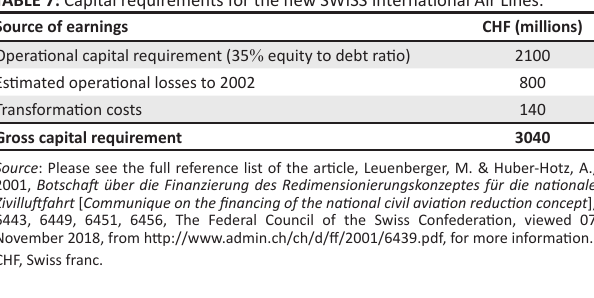
TABLE 8: Percentage shareholding in SWISS. Project